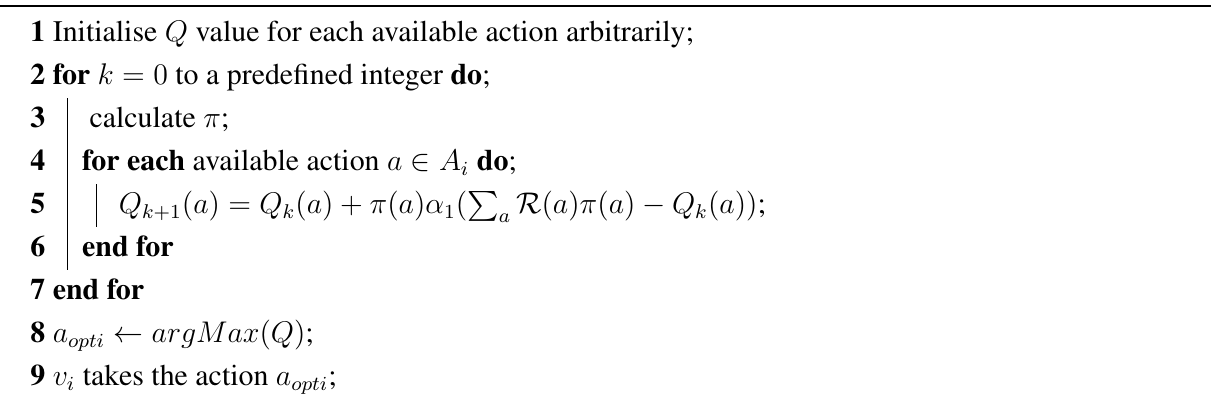
Algorithm 1. Learning progress of sensor v